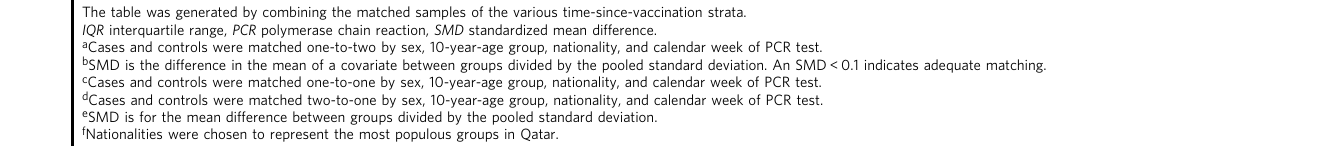
The table was generated by combining the matched samples of the various time-since-vaccination strata. IQR interquartile range, PCR polymerase chain reaction, SMD standardized mean difference. a Cases and controls were matched one-to-two by sex, 10-year-age group, nationality, and calendar week of PCR test. b SMD is the difference in the mean of a covariate between groups divided by the pooled standard deviation. An SMD<0.1 indicates adequate matching. c Cases and controls were matched one-to-one by sex, 10-year-age group, nationality, and calendar week of PCR test. d Cases and controls were matched two-to-one by sex, 10-year-age group, nationality, and calendar week of PCR test. e SMD is for the mean difference between groups divided by the pooled standard deviation. f Nationalities were chosen to represent the most populous groups in